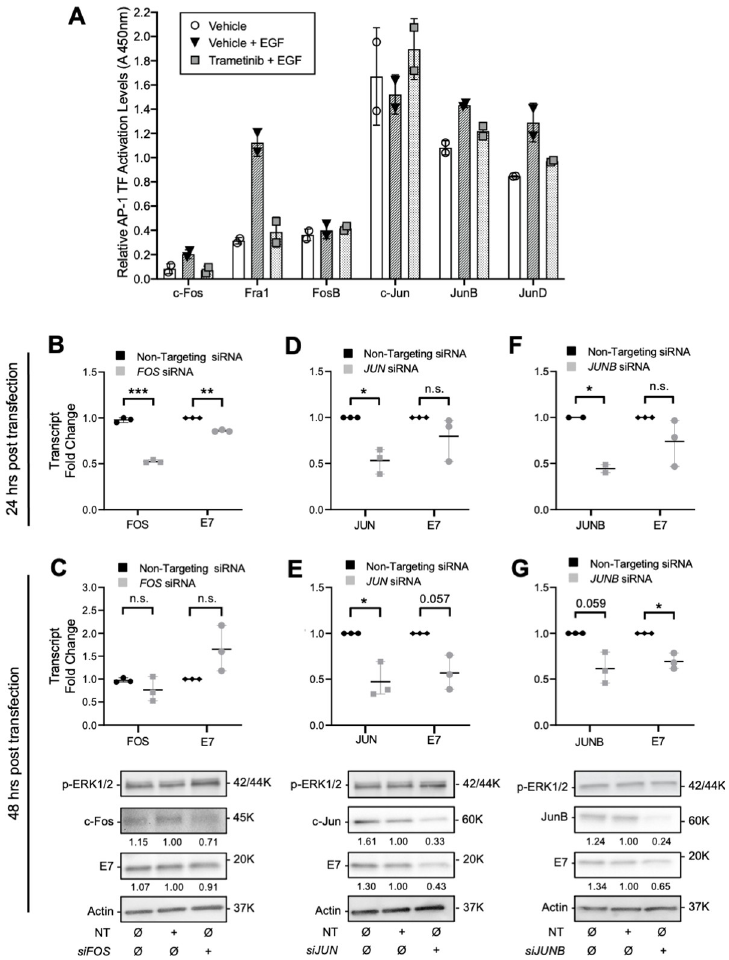
Fig 6. AP-1 transcription factors regulate HPV oncogene expression. (A) W12-E cells were seeded at high density and grown for 8h in the presence of DMSO or 50 nM trametinib prior to EGF stimulation. Nuclear extracts were collected 14h after EGF stimulation and assayed for the levels of each active AP-1 factor. (B-G) W12-E cells were serum starved for 4h prior to transfection with commercially available siRNA pools targeting FOS , JUN or JUNB mRNAs or non-targeting (NT) control siRNAs; these mRNAs encode the proteins c-Fos, c-Jun, or JunB, respectively. (B,D,F) Total mRNAs were extracted at 24h post transfection and subjected to RT-qPCR to quantify the AP-1 mRNAs and HPV E7 oncogene mRNAs. cDNA levels were normalized to those of ribosomal protein 18s and the values for NT siRNA transfected samples were set to one in each experiment. (C,E,G) At 24h post transfection, medium was replaced with serum-containing medium prior to harvesting for RNA and protein analyses at 48 post transfection Scatterplots represent the mean and range of the RT-qPCR data, which were analyzed by an unpaired Welch’s t-test ( � p < 0.05, �� p < 0.01, ��� p < 0.001). Protein lysates collected 48h post transfection were subjected to SDS-PAGE, IB and densitometry. Values directly below each lane represent the protein levels normalized to the NT siRNA transfected samples in each